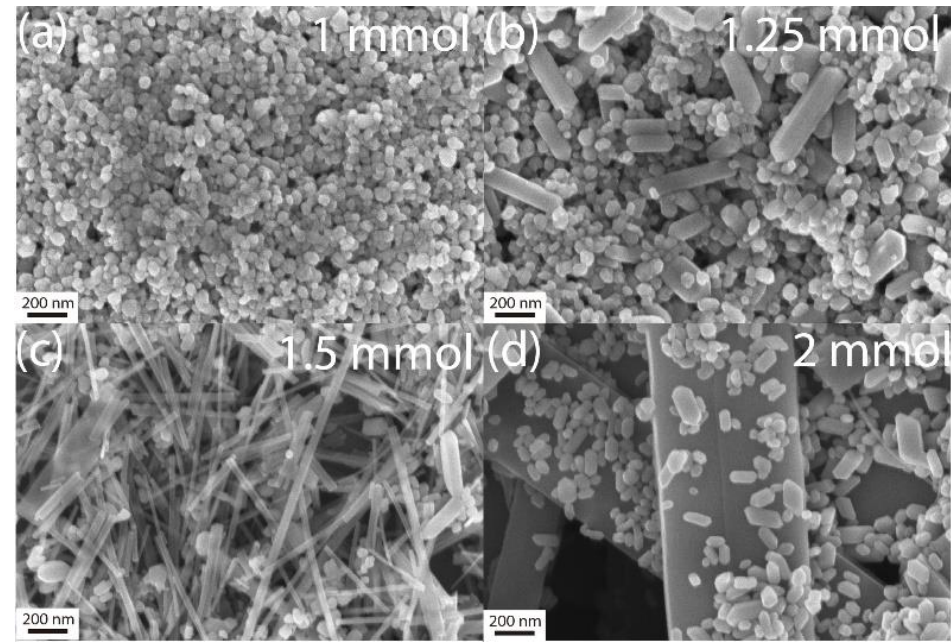
Figure 6. ( a – d ) SEM images of hydrothermal samples with different precursor concentrations at 260 °C with 60 μL N 2 H 4 ·H 2 O and 24 h duration.